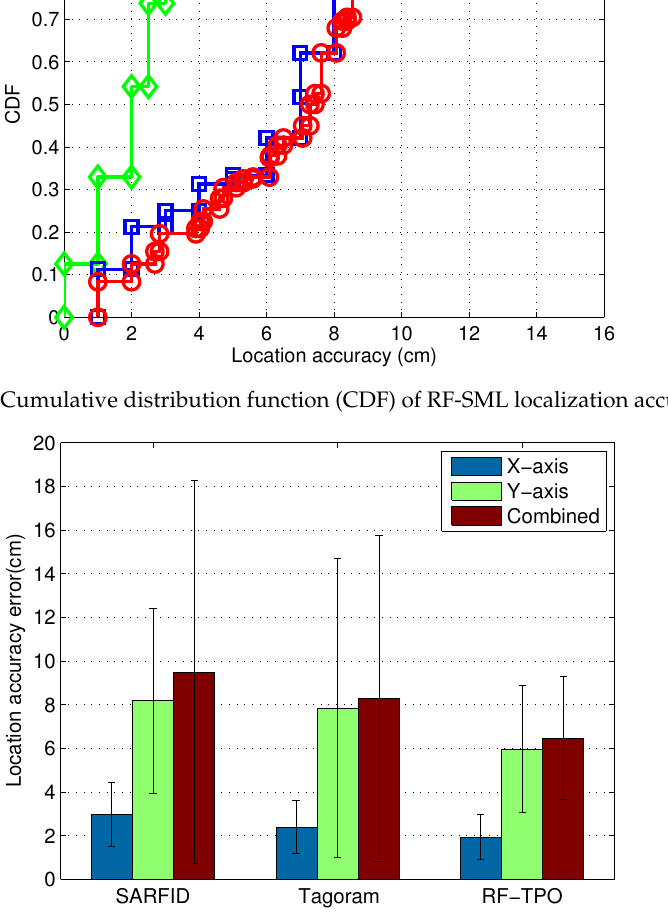
Figure 13. Localization accuracy error comparison among different methods. The bars represent the average localization accuracy errors in x-axis, y-axis, and combined dimension, respectively. Additionally, the whiskers represent the standard deviations of the corresponding localization accuracy